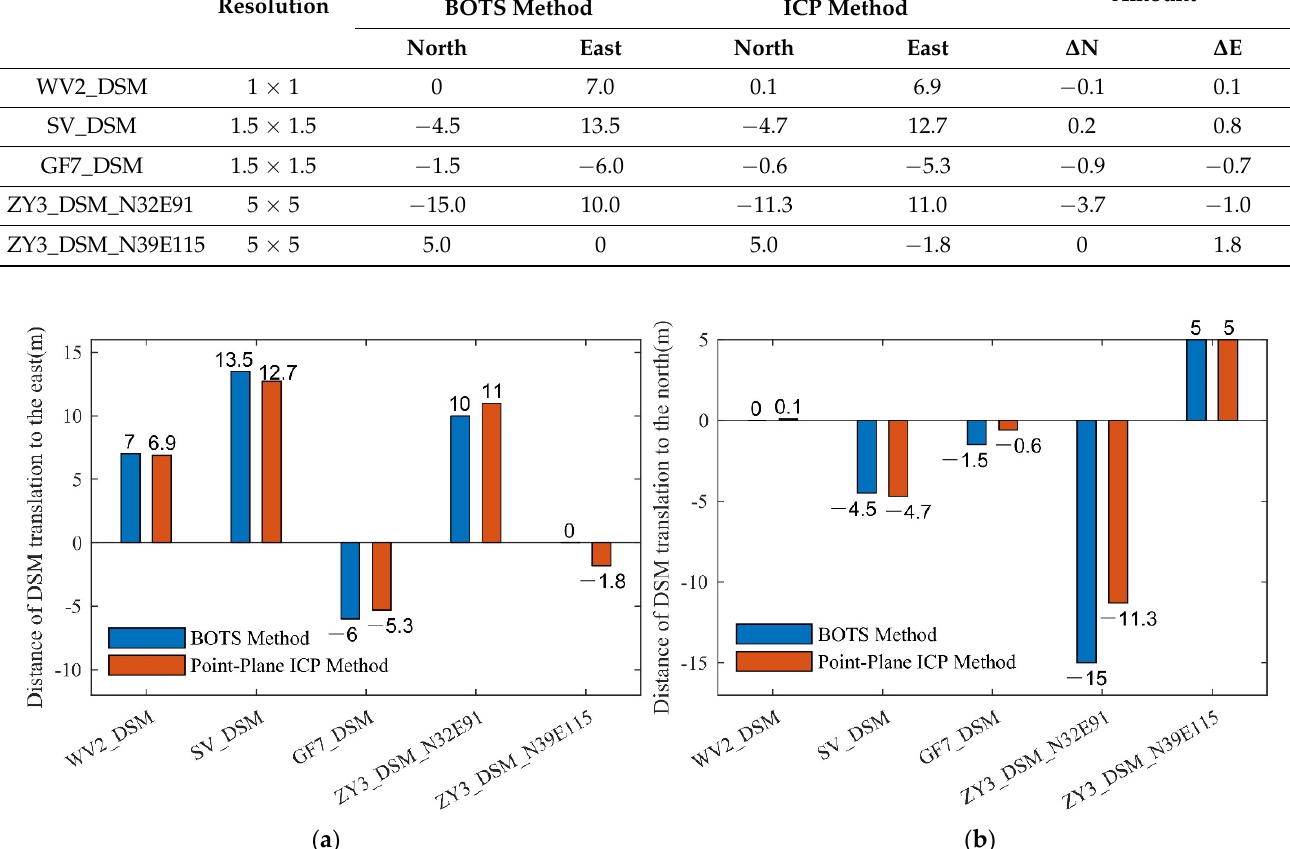
Figure 8. Registration DSM center horizontal translation amount: ( a ) is the amount of movement of each DSM center in the east-west direction, and ( b ) is the amount of movement of each DSM center in the north-south direction).